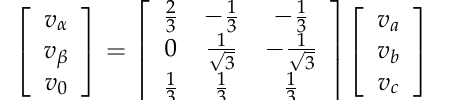
Figure 2. Frequency component of a sample fault in the network. 2.2. Neighborhood Component Analysis One step of the machine learning procedure that has a significant impact on its performance is feature extraction. There are several methods that can be used for finding more informative features from the input data to the algorithm. NCA is a non-parametric strategy that selects features using the nearest neighbor decision rule with the purpose of improving the prediction accuracy of regression and classification algorithms. When compared to state-of-the-art classification approaches such as SVMs and neural networks, the nearest neighbor is a simple and efficient non-linear decision process that often produces competitive results. In this part, the NCFS algorithm proposed in [35] is briefly reviewed. NCFS applies on the faulty data for identifying more effective features to decrease the dimension of the feature vector. Lowering the dimension of the feature vector by eliminating the less valuable features can enhance the accuracy of the classifier. With a